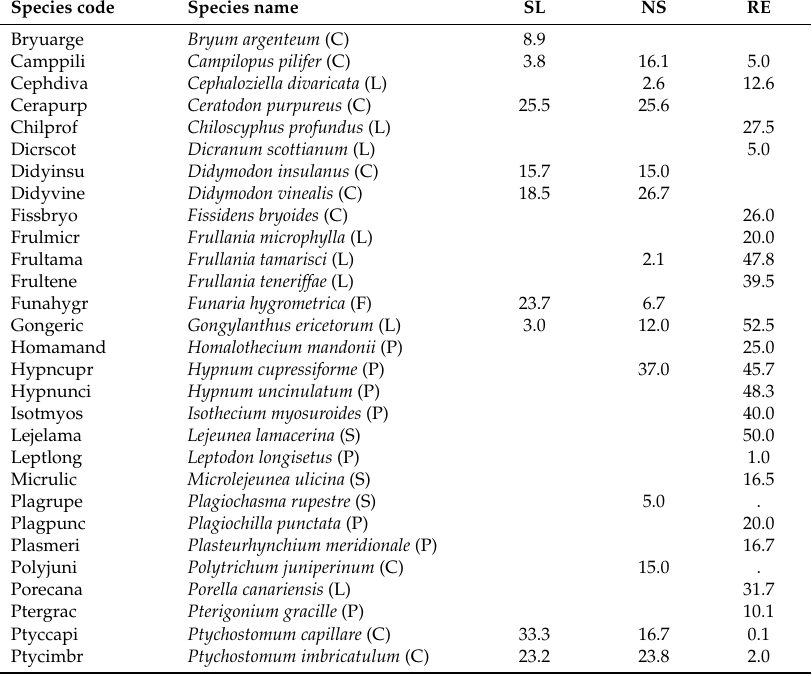
Table A1. Frequency of species recorded in the